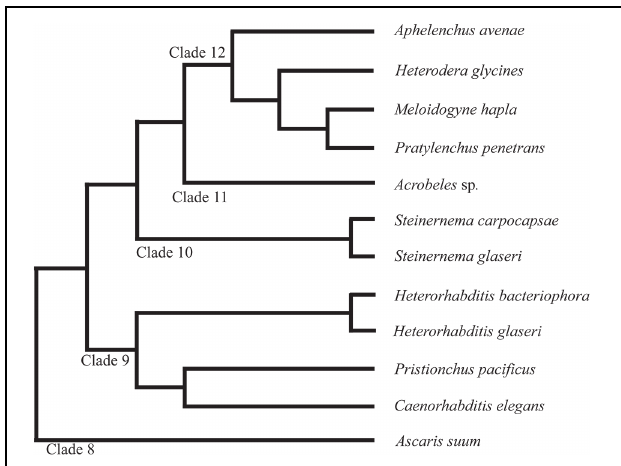
FIGURE 1 | Phylogeny of nematode species discussed in this study. The phylum Nematoda is currently divided into 12 clades as discussed in van Megen et al. (2009). Branch lengths do not represent